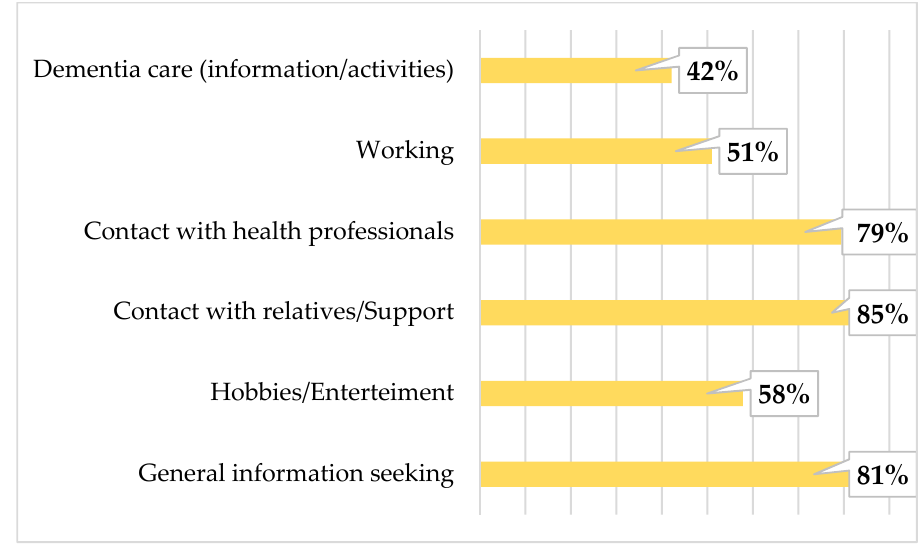
Figure 4. The purpose of smartphone use in caregivers.